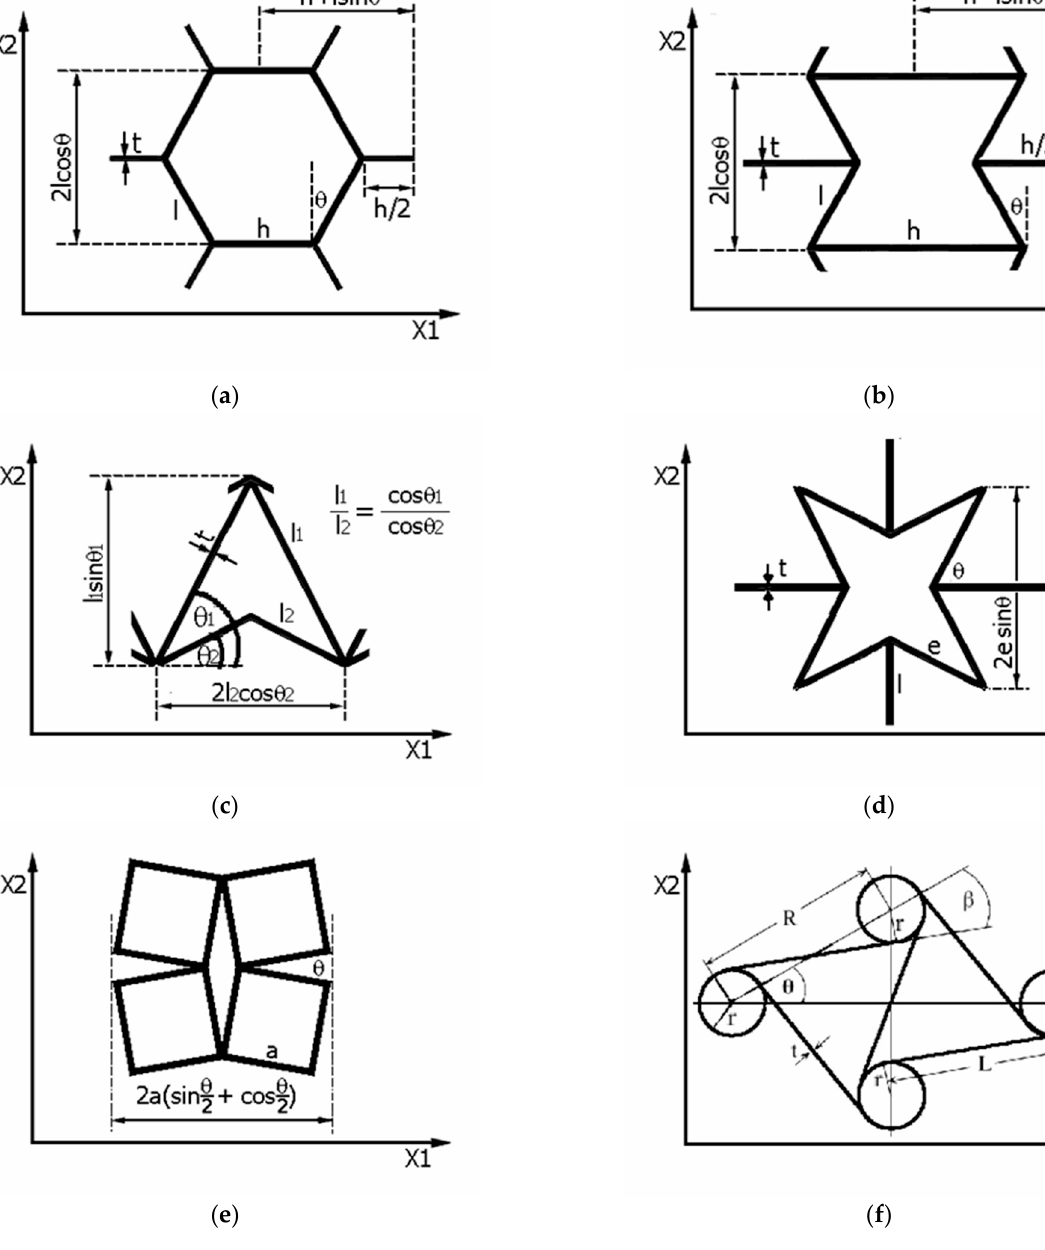
Figure 1. Commonly recognized unit cell models: convex and concave honeycomb unit cells ( a , b ), arrowhead ( c ), star ( d ), rotating squares ( e ), and chiral cells ( f ).